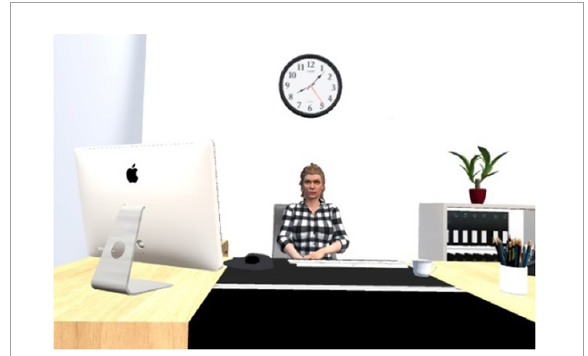
FIGURE1 The virtual reality adaptation of the Rey Auditory Verbal Learning Test (VR-RAVLT). For RAVLT episodic, verbal memory test—recall of 15 items is tested five times sequentially (learning curve), once again after a new interference list (retroactive interference) and then again after 20 min (delayed recall). In the VR-adapted test, recall of the non-semantically related items is replaced by recall of real-life places-to-go dictated by a virtual personal assistant